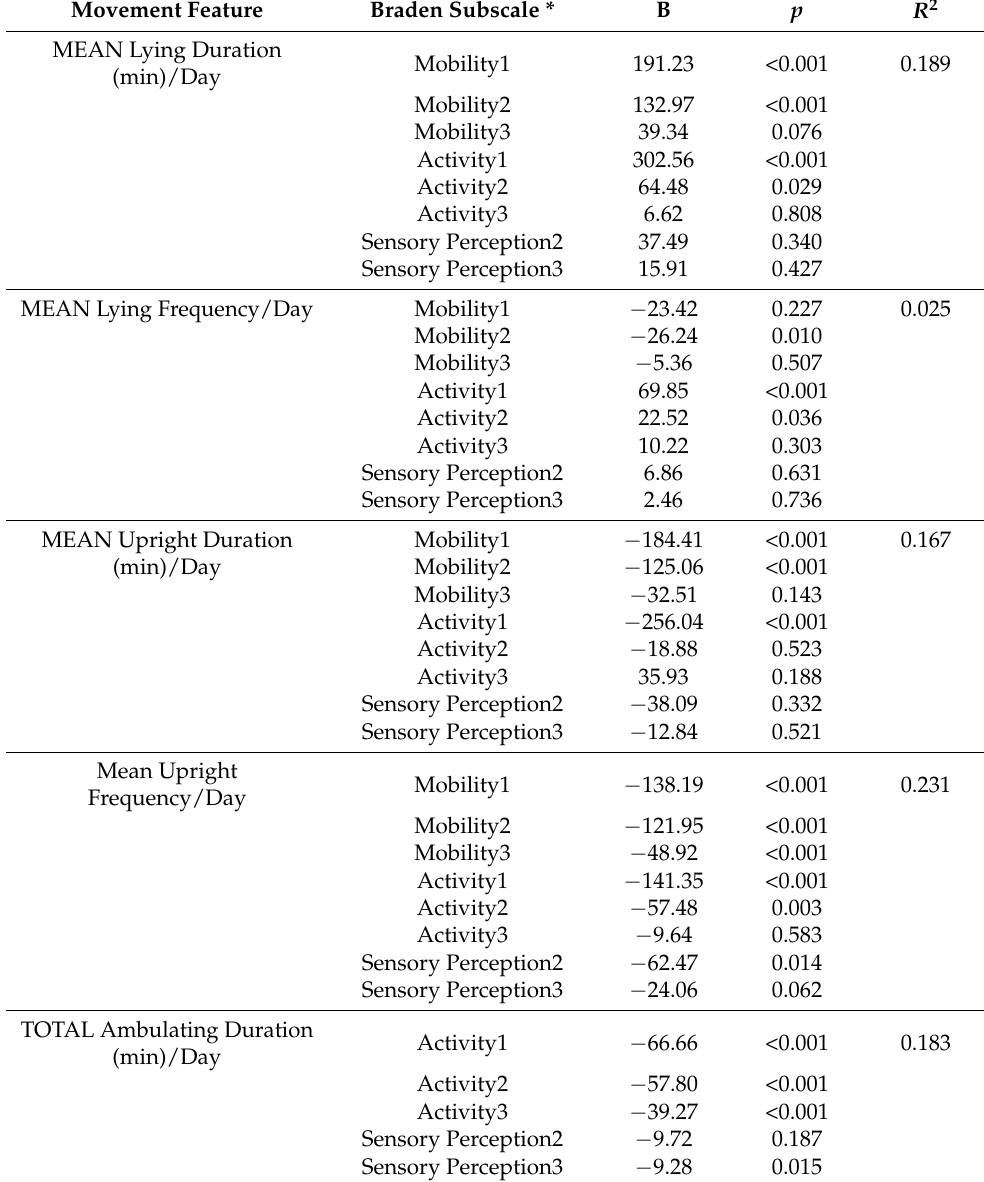
Table 5. Ordinary Least Squares Regression Models Predicting Movement Features Using Dummy Variable Constructs for Each Braden Mobility, Activity, and Sensory Perception Subscale Score (N = 913). Movement Feature Braden Subscale * B